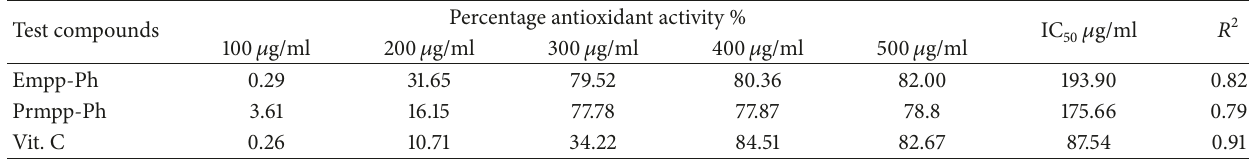
Table 2: Antioxidant scavenging activity data of Empp-Ph and Prmpp-Ph